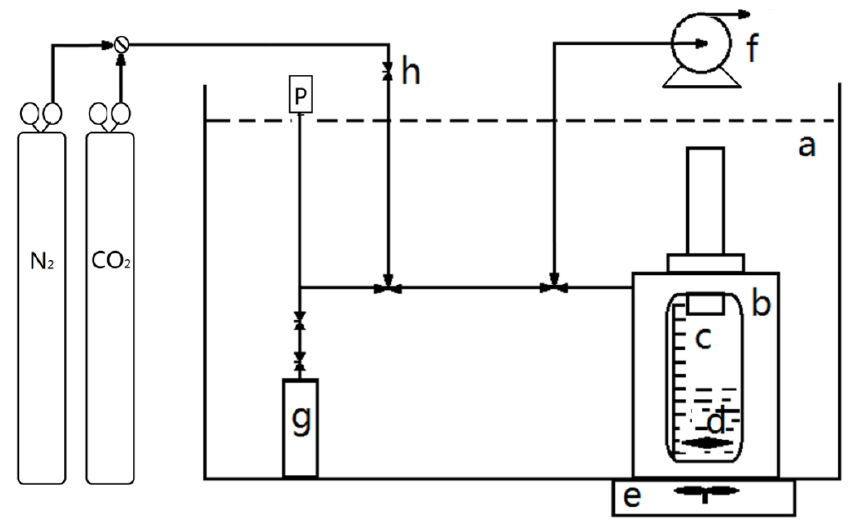
Figure 6. Apparatus for the solubility measurements: a, water bath; b, high-pressure cell; c, volume scale; d, magnetic stirring bar; e, magnetic stirrer; f, vacuum pump; g, gas storage tank; h, needle valve; P, pressure